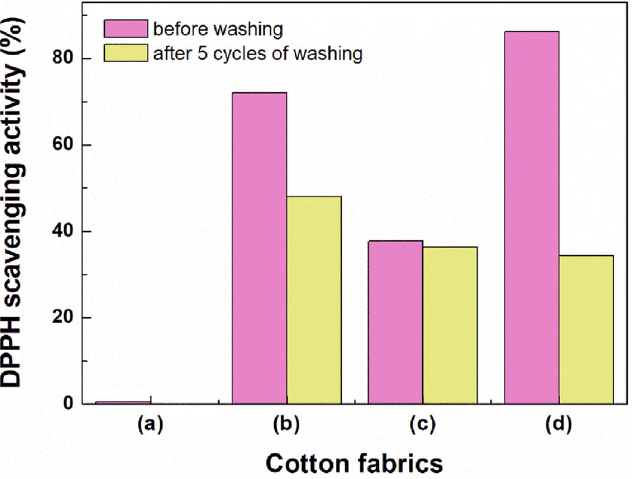
Fig. 9 Antioxidant capacity of cotton fabrics: a untreated, b dyed with Aronia berries extract, c dyed with the Aronia berries extract–chitosan mixture, and d dyed with Aronia berries extract after chitosan